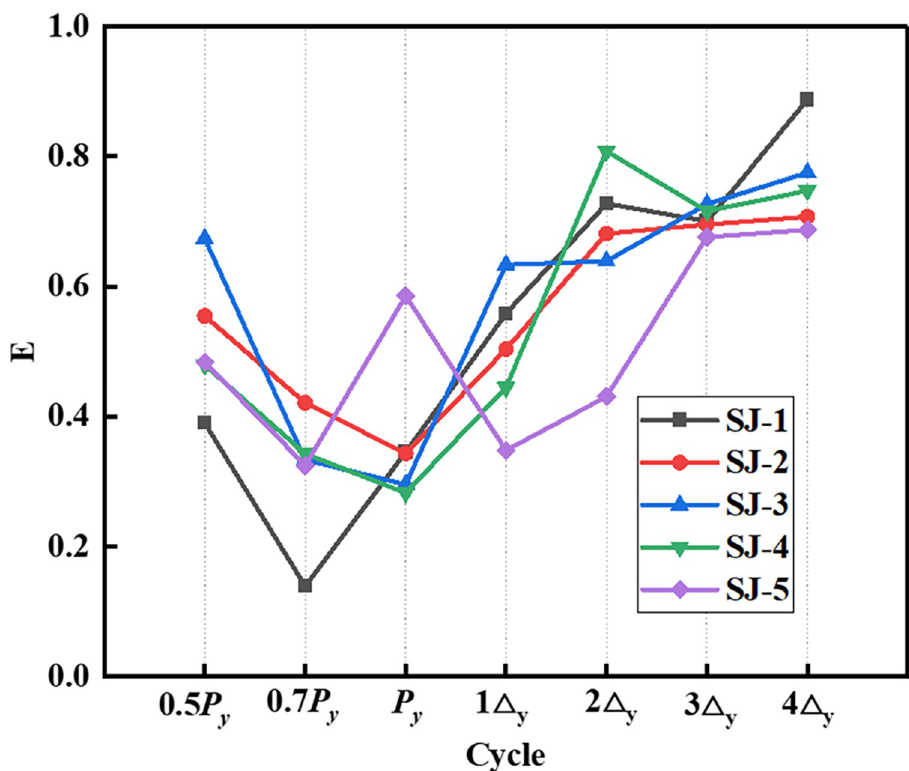
Fig 25. Energy dissipation coefficient of the five specimens.